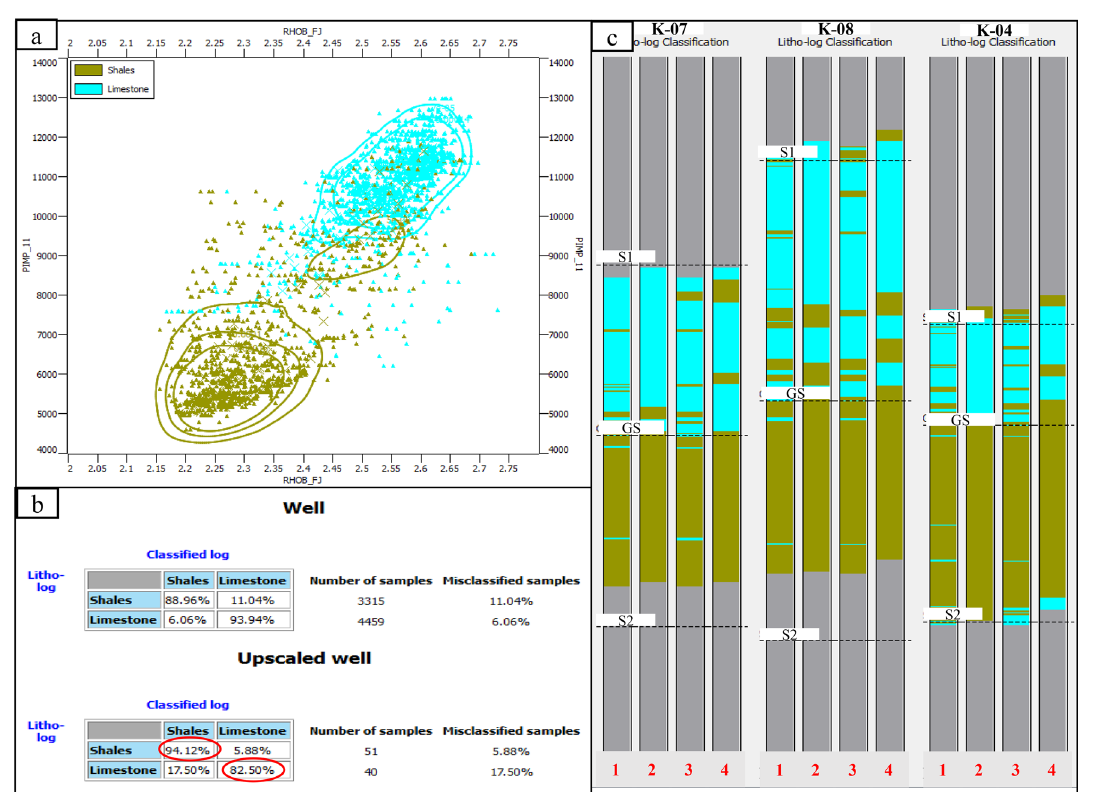
Fig. 18 a Accumulative multivariate pdf calculated from Zp versus density cross-plot opted for the litho-facies classification schemes, b confidence matrix provided the probability of each defined facies and